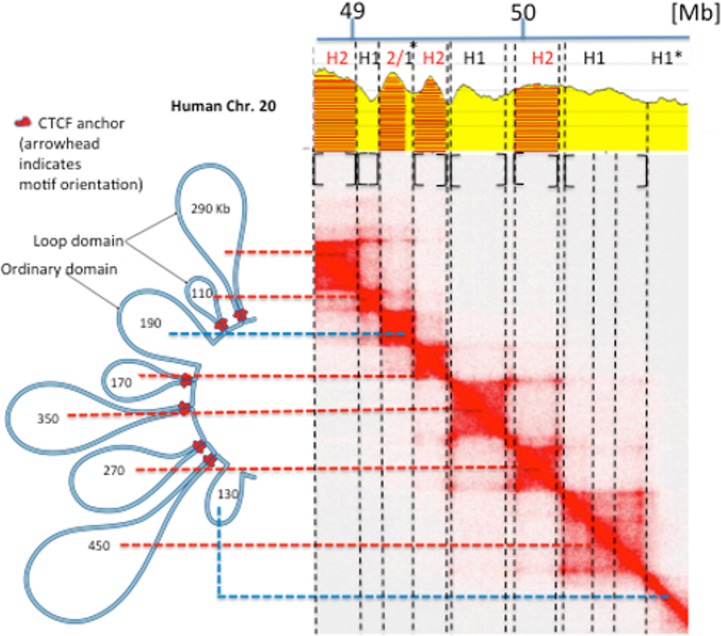
Chromatin loops and isochores from a 2.1 Mb region of human chromosome 20.The chromatin loops from a 2.1 Mb region of human chromosome 20 (Fig 6F from [3]) have been aligned with the corresponding heat map which was used to segment the corresponding DNA sequence into isochores. In this Figure the “extended” isochore ranges of Table A in S1 File were used to assign isochores to families, in order to take care of some minimal trespassings of the 46% GC upper threshold of H1 isochores. Asterisks indicate anomalies in the isochores/domains correspondence (see Text).